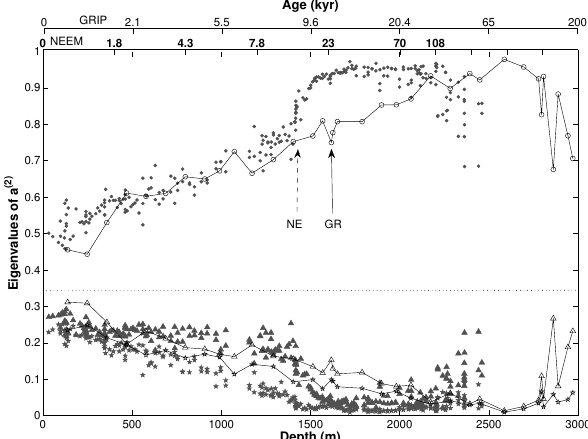
Figure 4. Comparison between the fabric profiles along the NEEM ice core (filled symbols) and the GRIP ice core (open symbols) (dot: a ( 2 ) , triangle: a ( 2 ) , star: a ( 2 ) ) (Thorsteinsson et al., 1997; Svens- 1 2 3 son et al., 2009). Arrows indicate the HW climatic transition (NE: NEEM, GR: GRIP). Top axes: approximate age scales for both